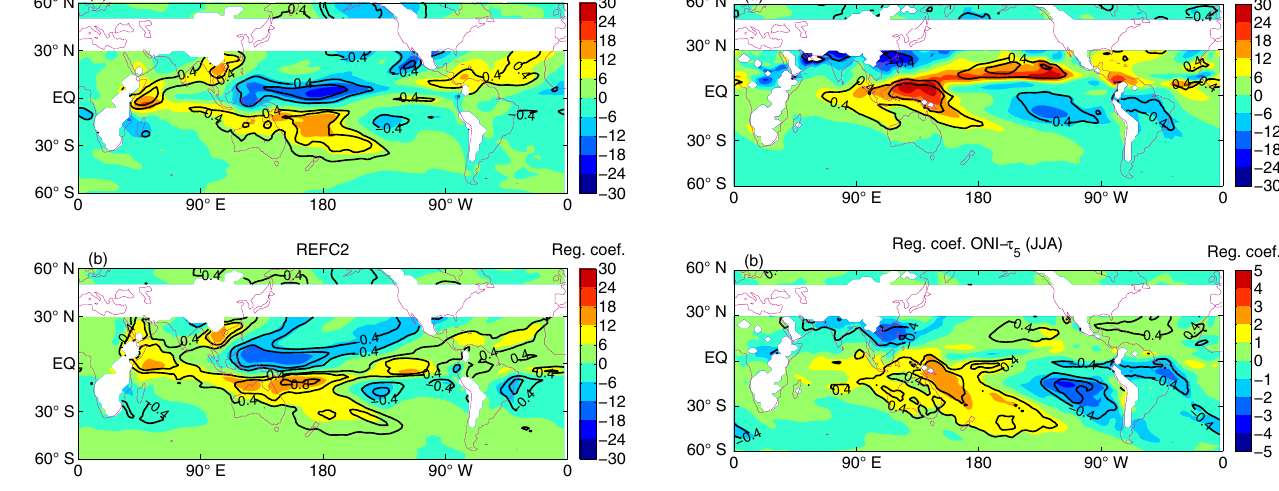
Figure 10. As in Fig. 9a but for CAM4Chem (a) REFC1 and (b) REFC2 simulations.